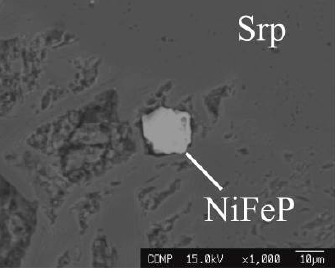
Figure 10. Back-scattered electron (BSE) image of a Ni–Fe phosphide found in the interstitial serpentine of the Bakanov Kluch chromitite.